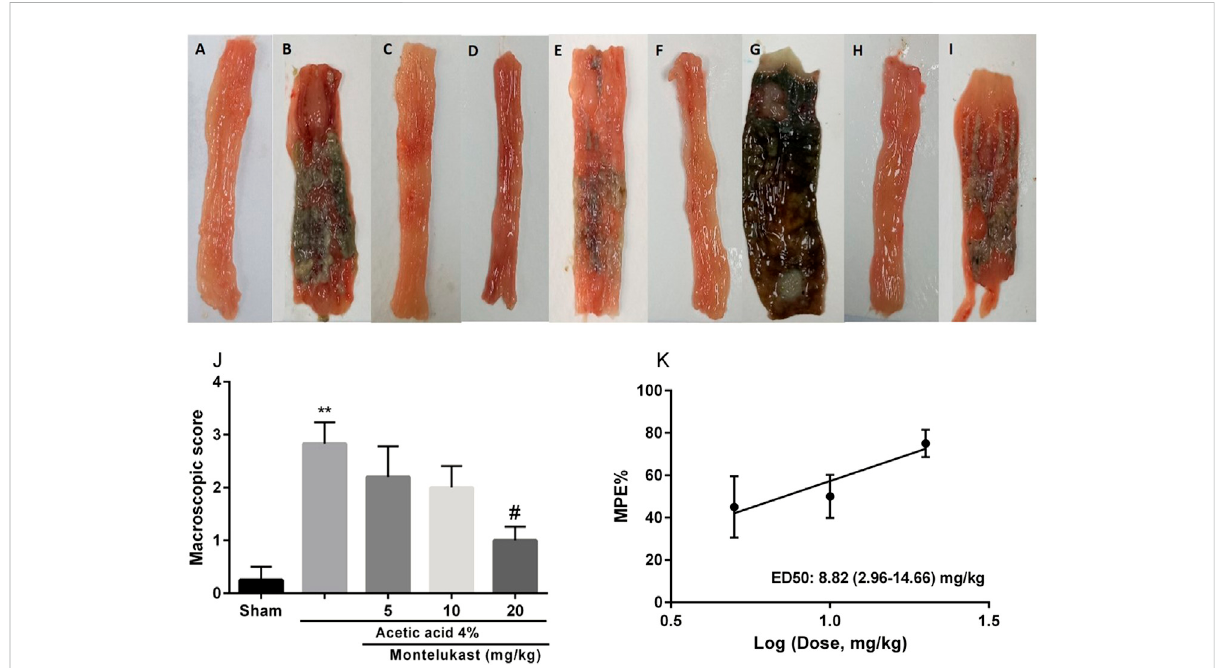
FIGURE 1 Effect of montelukast (Mon) on the macroscopic score of colon tissue (A) Sham; (B) acetic acid group (C) Mon (20 mg/kg) (D) Mon 20 + L-arg; (E) Mon 20 + L-NAME (F) Mon 20 + sildena fi l (sil) (G) Mon 20 + Methylene blue (MB) (H) Mon 20 + diazoxide (Diaz) (I) Mon 20 + glibenclamide (Gli). Evaluation of the macroscopic scores and ED50 value (with 95% con fi dence limits) of Mon for the protective effect shown in panels (J) and (K) , respectively. The results are expressed as the means ± SEM of six rats per group. ** p < 0.01, when compared to the Sham group; ## p < 0.01 when compared to the acetic acid group. The statistical analysis was performed by ANOVA followed by Tukey ’ s post hoc test. %MPE: Maximal possible effect.